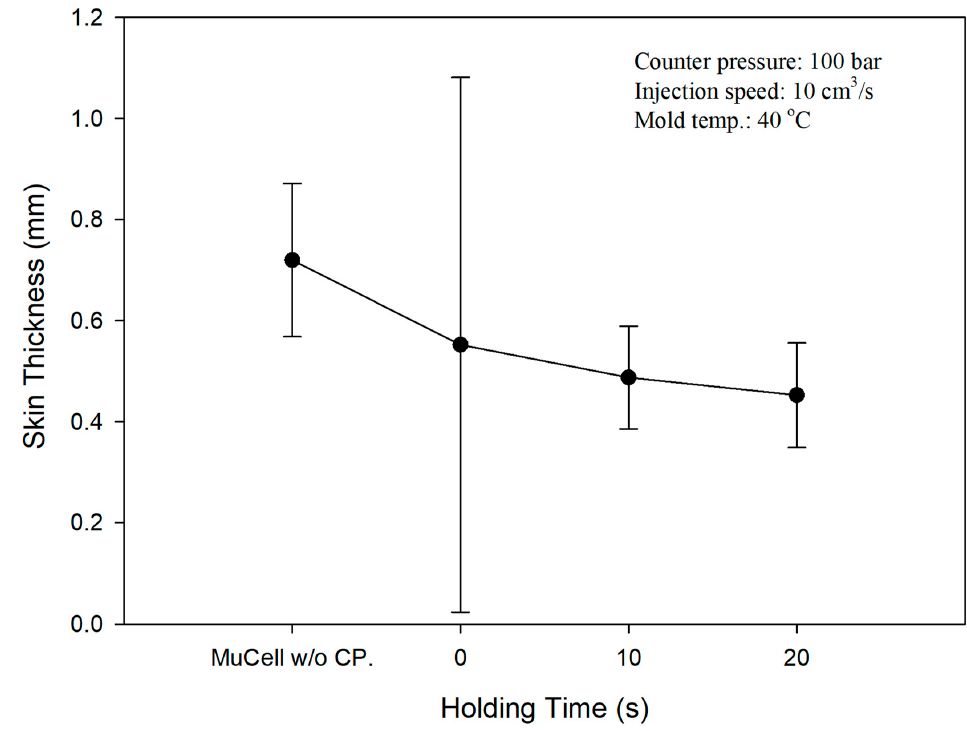
Figure 9. Skin layer thickness measured at the middle position of the microcellular molding with/without GCP and different holding times.